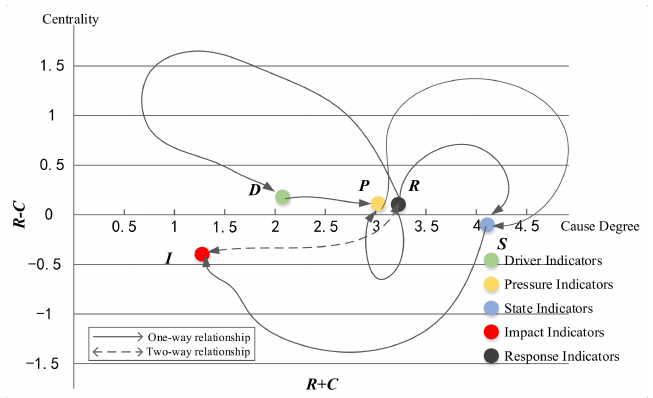
Figure 4. Causal relationships between the